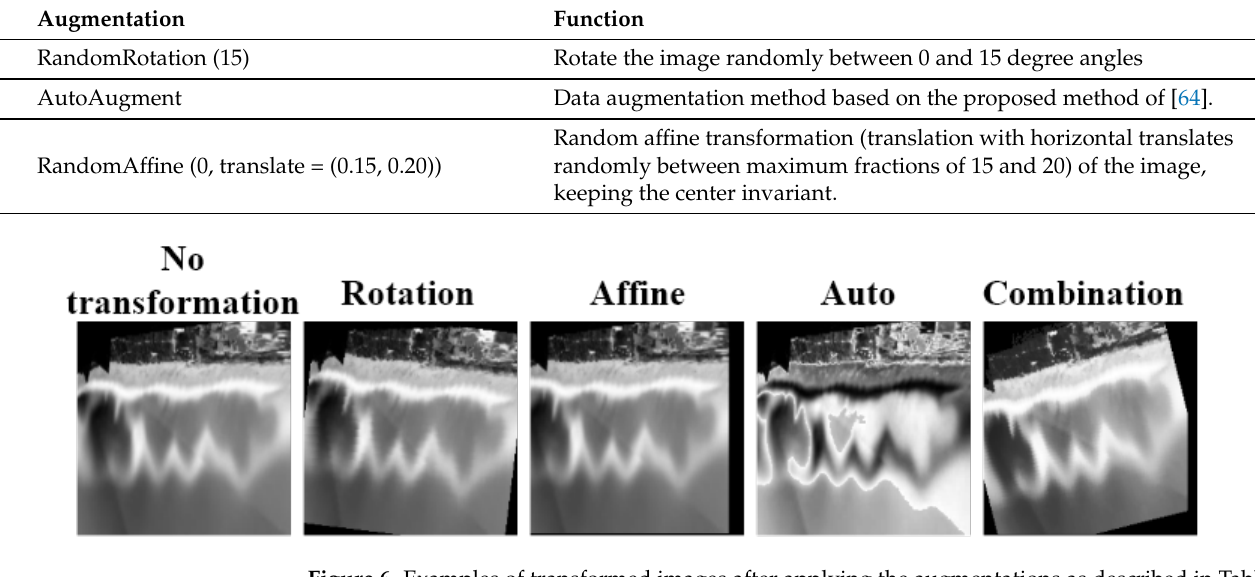
Figure 6. Examples of transformed images after applying the augmentations as described in Table 3: RandomRotation, RandomAffine, AutoAugment and the combination of the